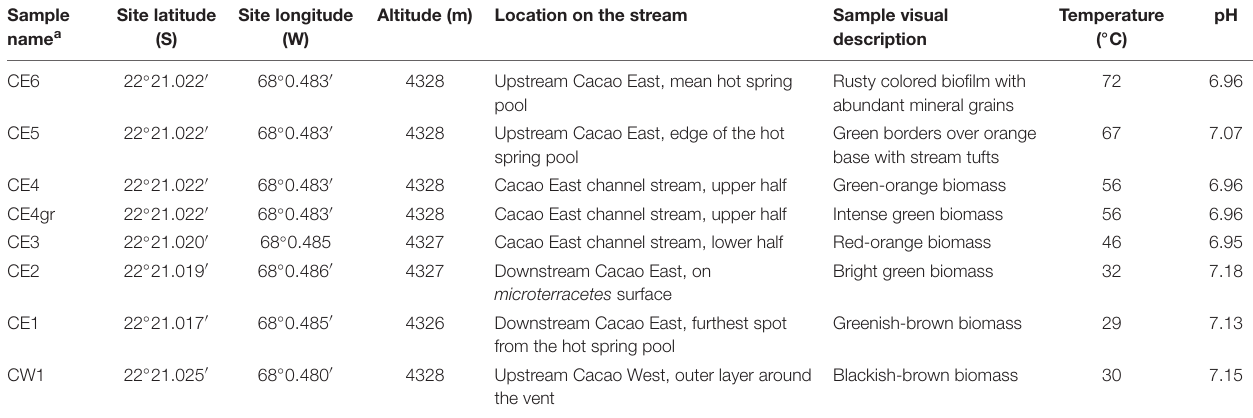
TABLE 1 | Location and description of the fresh biofilms studied along the Cacao hydrothermal stream, in the El Tatio middle